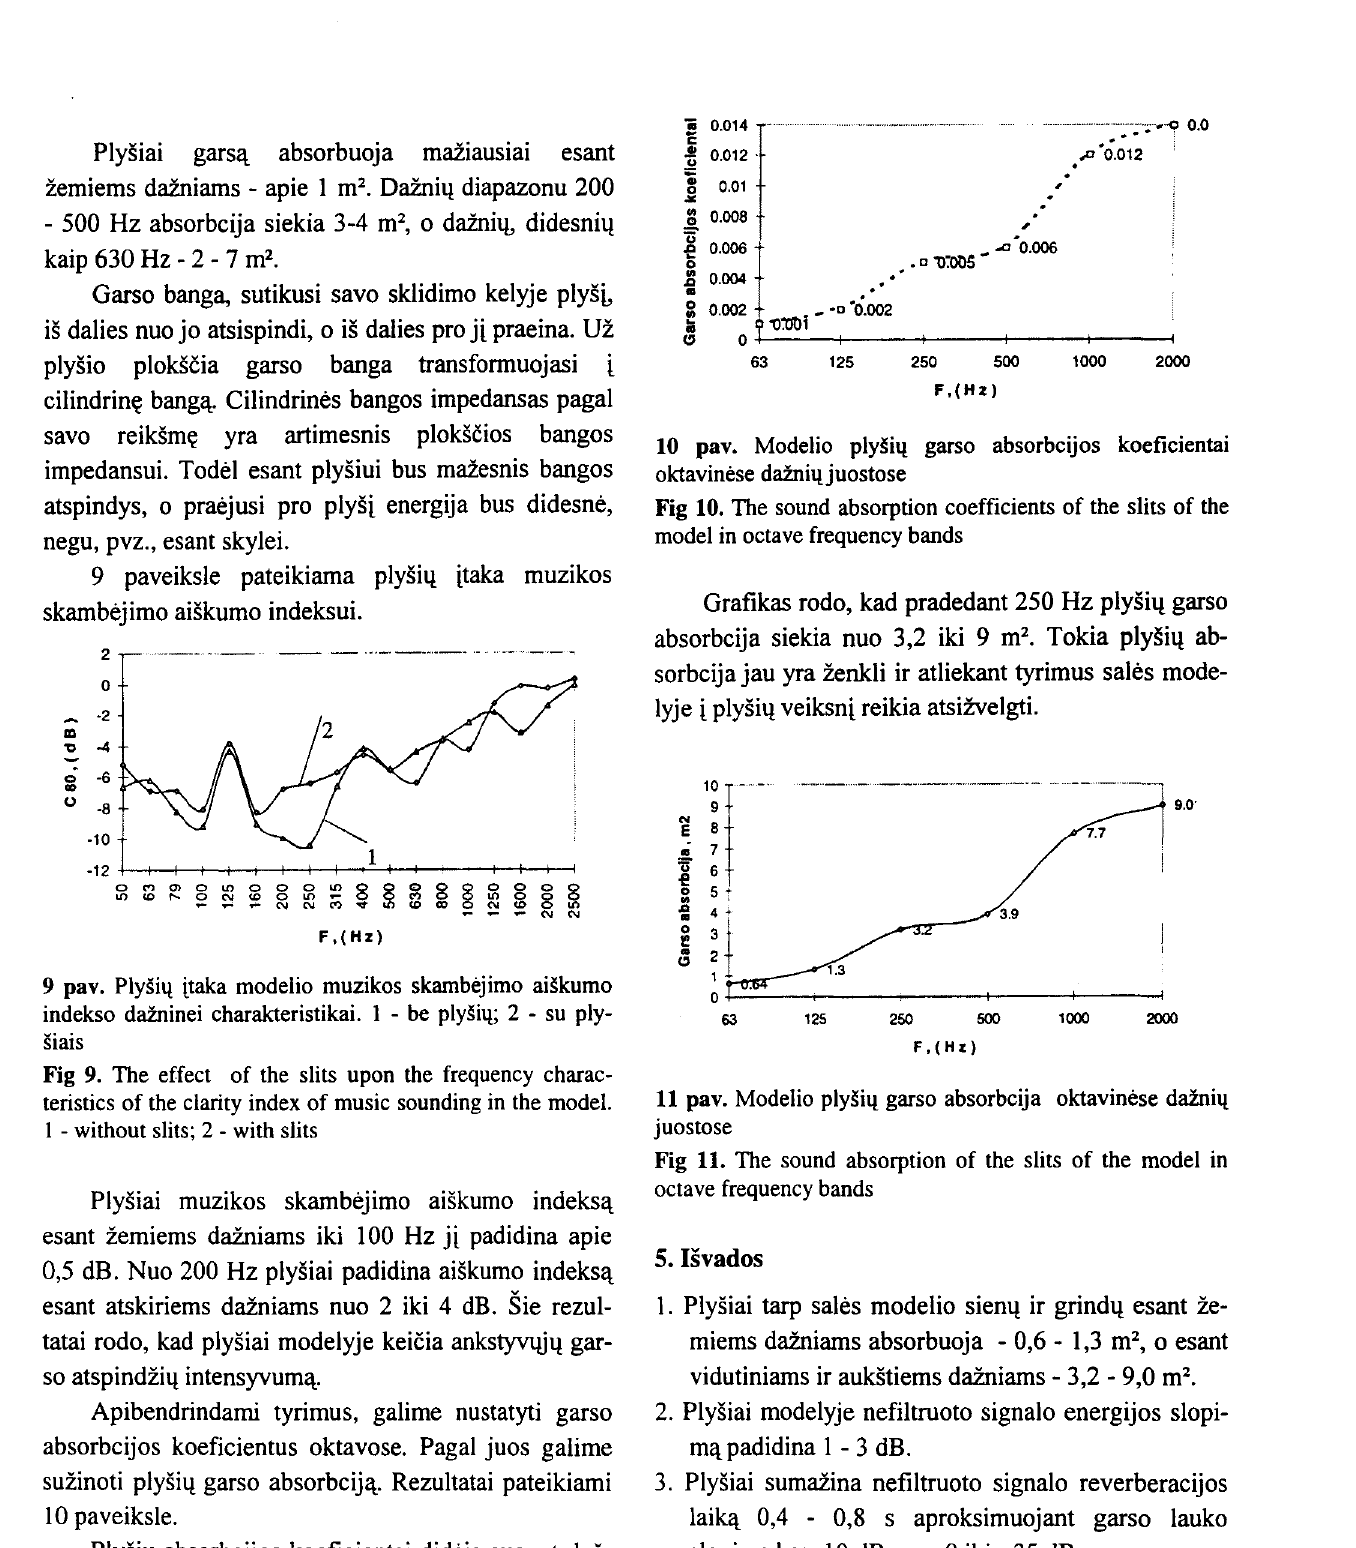
Fig 11. The sound absorption of the slits of the model in octave frequency bands 5. ISvados 1. Plysiai tarp sales modelio sienq ir grindq esant ze miems daZI1iams absorbuoja - 0,6- 1,3 m 2 , o esant vidutiniams ir aukstiems daZI1iams- 3,2-9,0 m 2 • 2. Plysiai modelyje nefiltruoto signalo energijos slopi ffil\. padidina 1 - 3 dB. 3. Plysiai sumaiina nefiltruoto signalo reverberacijos laikl\_ 0,4 - 0,8 s aproksimuojant garso lauko slopiml\_kas IO dB, nuo 0 iki- 35 dB. 4. Plysiai sumaiina standartini reverberacijos laikl\. 0,4 - 0,6 s visu daZI1iq